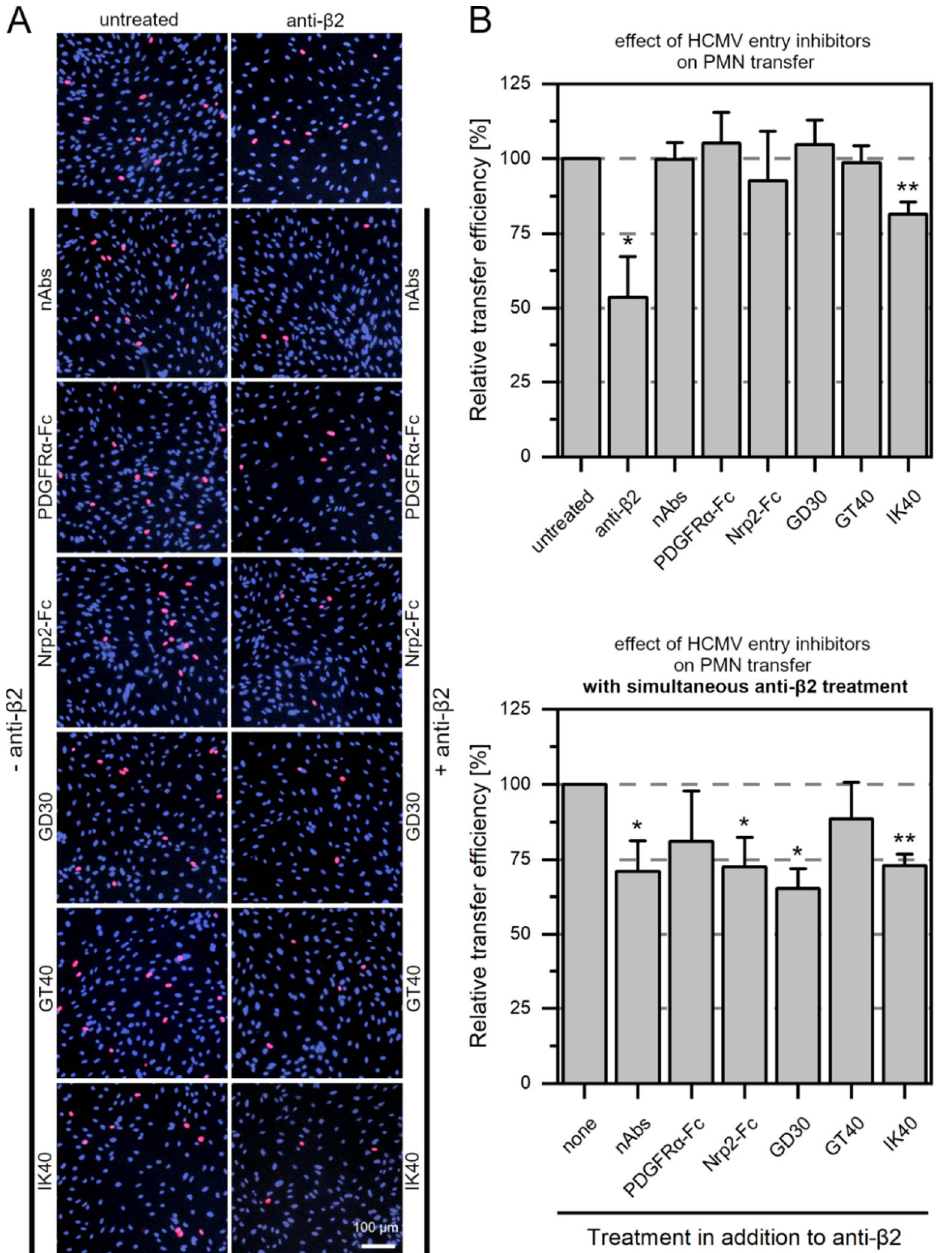
Figure 10. Entry inhibitors reduce PMN-mediated transfer of HCMV isolates to endothelial cells when the β2 subunit of LFA-1 is blocked. PMNs were isolated from EDTA blood of HCMV-seronegative donors and incubated for 3 h at 37 °C with clinical isolate donor cultures. PMNs were recollected and either left untreated or were treated for 30 min at 37 °C with 20 μg/mL anti-integrin β2 (subunit of LFA-1). Then, they were incubated with uninfected recipient HEC-LTTs and HCMV inhibitors for 3 h at 37 °C. HCMV-specific hyperimmunoglobulin (nAbs), recombinant PDGFRα-Fc, recombinant Nrp2-Fc, or the PDGFRα-derived peptides GD30, GT40 and IK40 were added at 0.5 mg/mL, 120 ng/mL, 590 ng/mL or 0.45 mg/mL, respectively. PMNs were removed, and HEC-LTTs were incubated overnight. On the next day, cells were fixed and stained for viral IE Ag via indirect immunofluorescence (pink nuclei). Cell nuclei were counterstained with DAPI (purple nuclei). ( A ) Representative exemplary images for recipient HEC-LTTs after PMN-mediated transfer in the presence of HCMV inhibitors with or without anti-integrin β2 treatment. ( B ) The transfer efficiency in the presence of each inhibitor was calculated and is shown relative to the transfer efficiency of untreated cells (upper graph) or cells treated with anti-integrin β2 only (lower graph). Error bars represent the standard error of the mean of 3 individual experiments. Asterisks indicate significant differences as compared to the untreated control (* p -value < 0.05, ** p -value < 0.01).